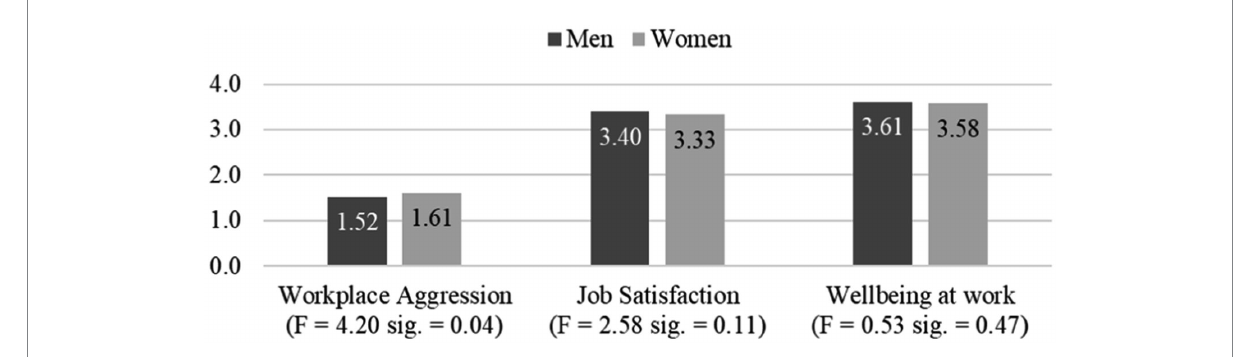
FIGURE 2 Workplace Aggression, Job Satisfaction, and Wellbeing at Work by